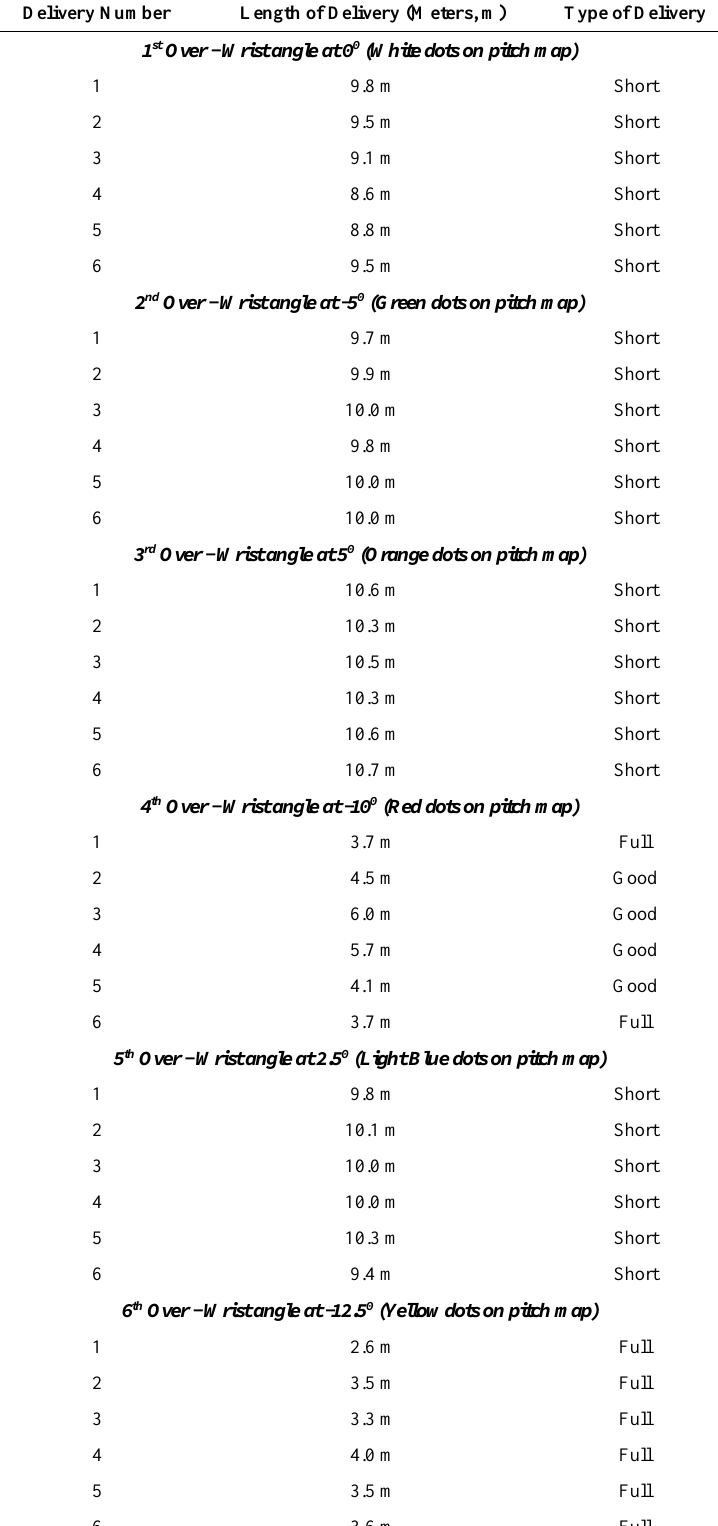
Table 2. Table of results for 9 overs